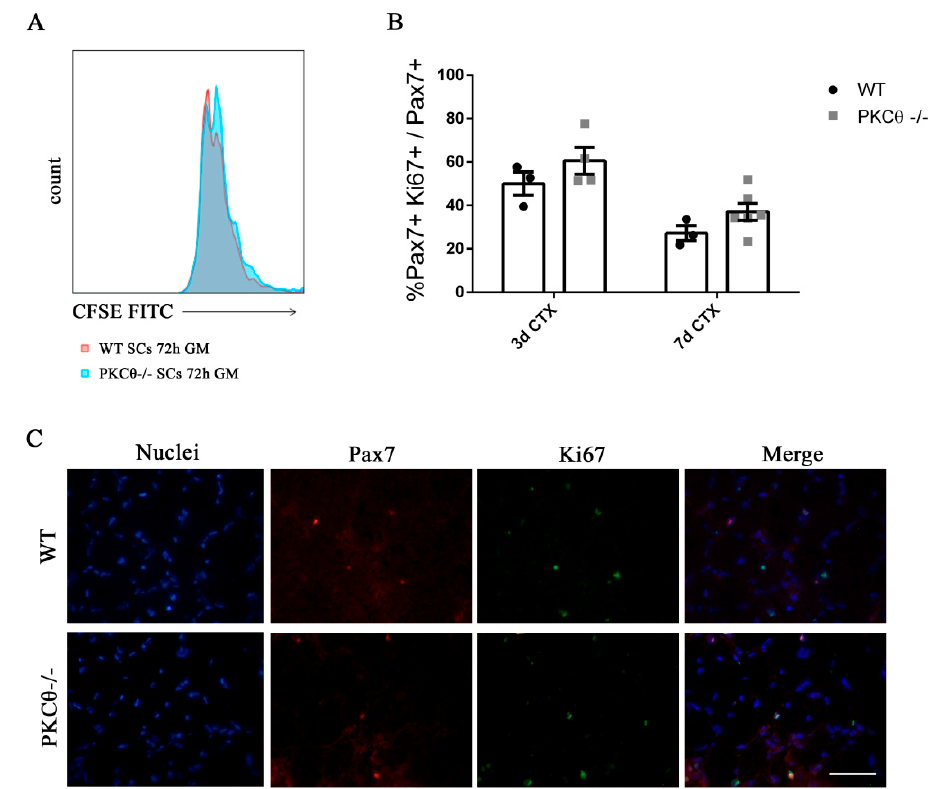
Figure 2. Knock out of Protein kinase C Theta (PKC θ ) does not a ff ect satellite cell (SC) proliferation. ( A ): Flow-cytometry analysis of CFSE stained WT and PKC θ - / - SCs, cultured for 72h in GM. ( B ): Percentage of proliferating SCs, identified by immunofluorescence asPax7 + / Ki67 + cells on WT and PKC θ - / - GA muscle sections, 3 and 7 days after CTX injury, over the total Pax7 + cells. ( C ): Representative immunofluorescence images of WT and PKC θ - / - GA muscles, stained for Pax7 and Ki67, 3 days after the induction of CTX injury, scale bar: 100µm.